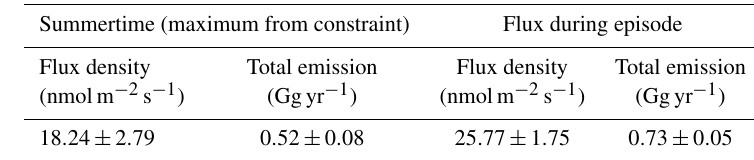
Table 1. Maximum fluxes of methane from the ocean at the North Svalbard location determined from summer data and the flux during the episode of high CH 4 mixing